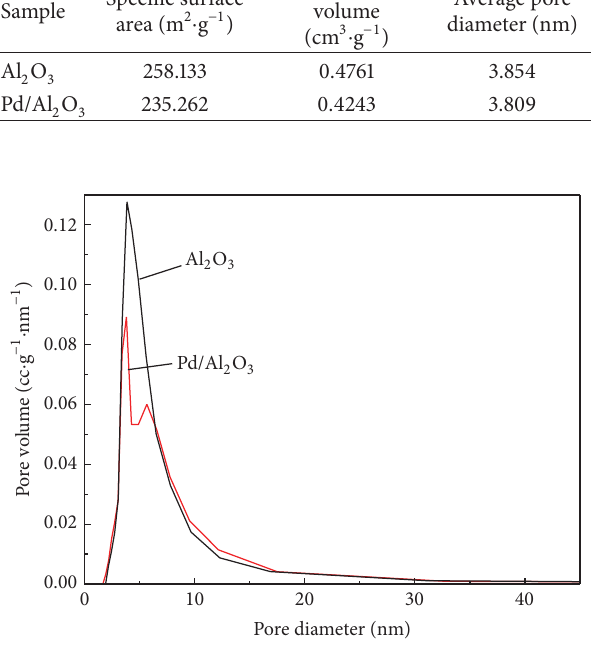
Figure 12: The pore diameter of Al 2 O 3 and 1% Pd/Al 2 O 3